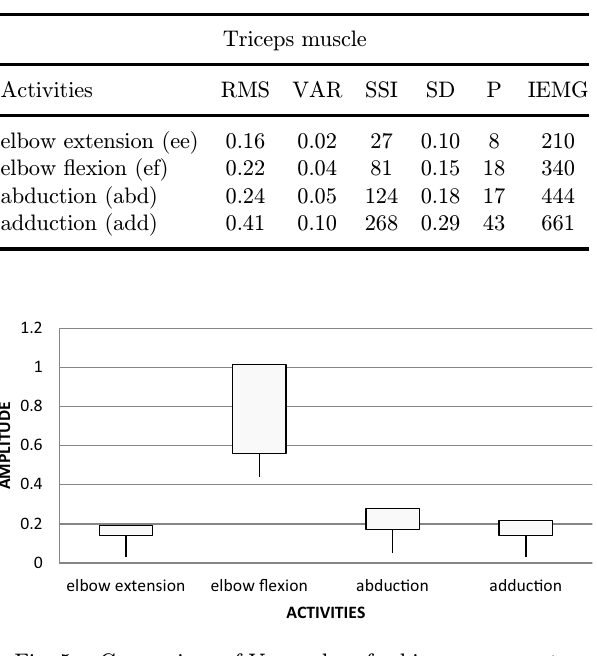
Fig. 5. Comparison of V rms values for bicep movements.